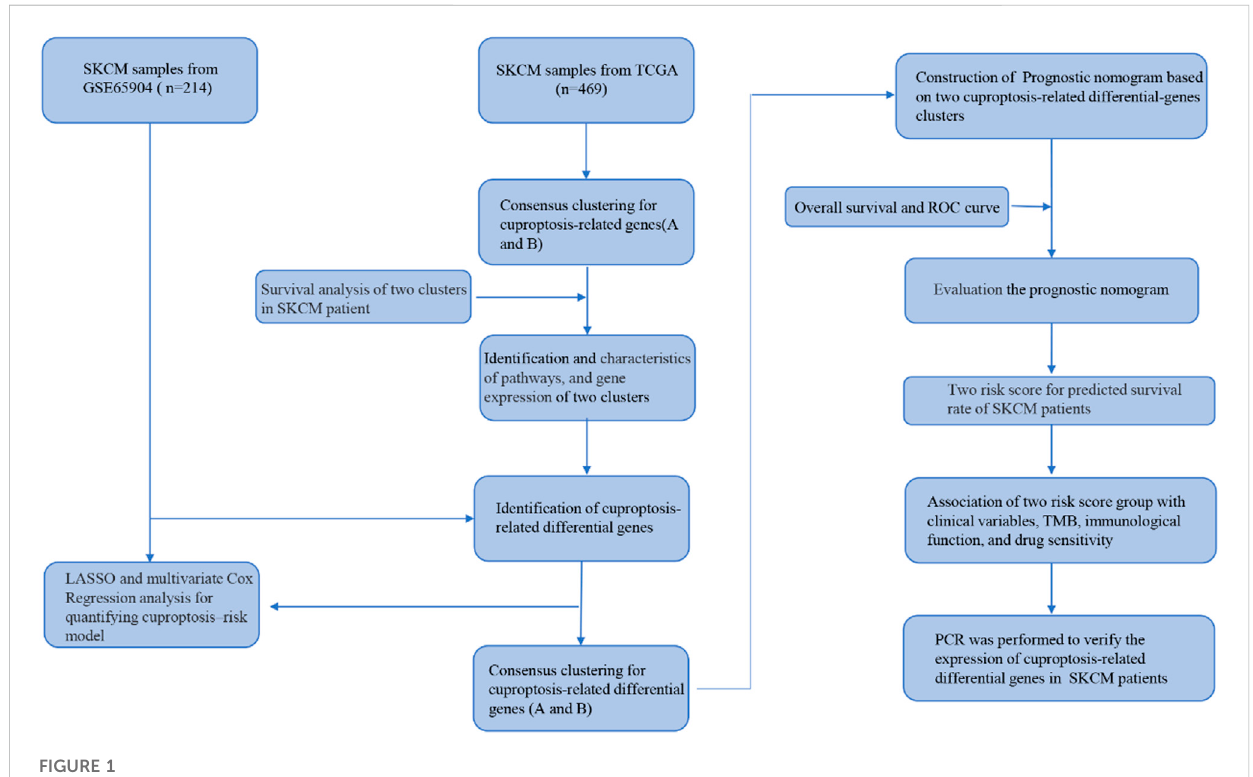
FIGURE 1 A fl ow chart showing the analysis